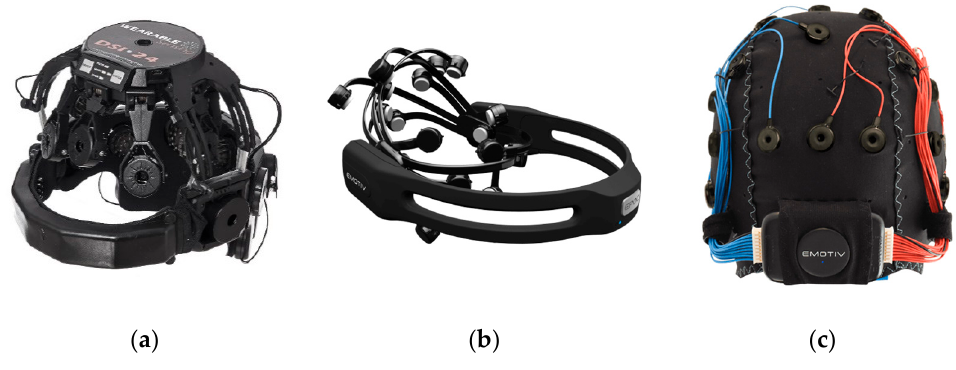
Figure 1. ( a ) dry, ( b ) saline solution, ( c ) gel-based.